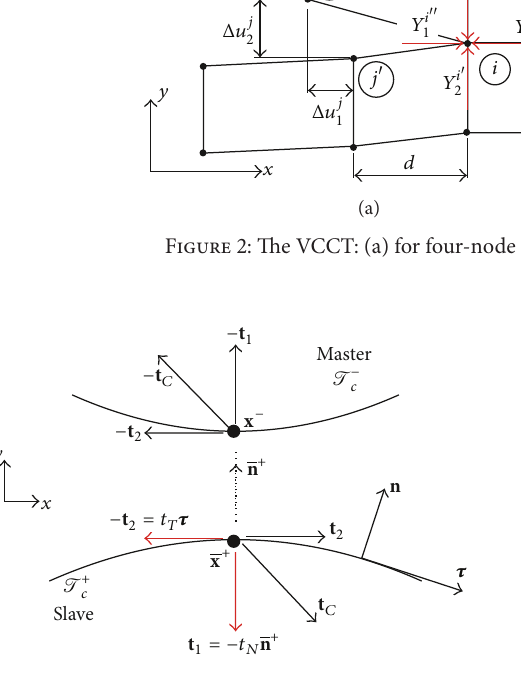
Figure 3: Two-dimensional contact